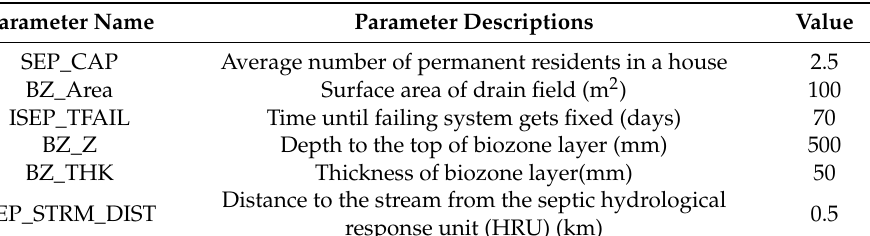
Table 1. Onsite wastewater treatment system (OWTS) input parameter.